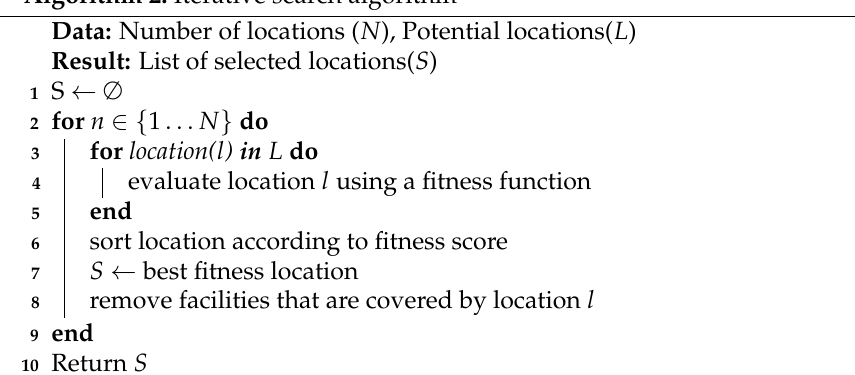
Algorithm 2: Iterative search